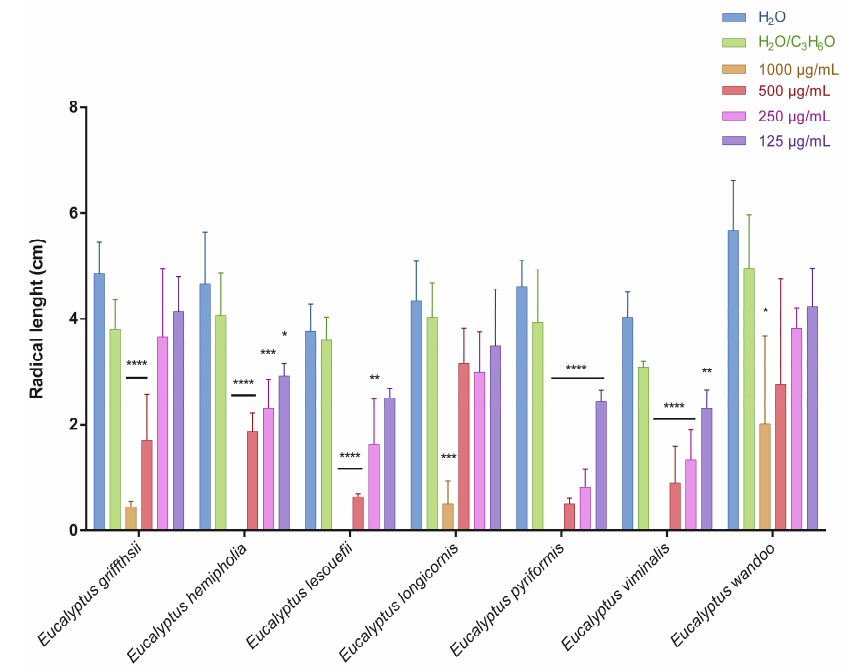
Figure 6. Radical length of Lolium multiflorum seeds after treatment with different concentrations (125–1000 µ g/mL) of Eucalyptus essential oils measured 120 h after sowing. Results are the mean ± standard deviation ( n = 3) of three independent experiments. * p < 0.05; ** p < 0.01, *** p < 0.001, **** p < 0.0001 compared to control (ANOVA followed by Dunnett’s multiple comparison test). The EOs from E. lesouefii and E. pyriformis were the most active against germination and radical elongation of S. arvensis . In fact, at the lowest doses tested (125 µ g/mL), the inhibition of germination was 93.1 and 96.6%, respectively, and the inhibition of radical elongation was 90.6 and 94.8%, respectively. E. griffithsii and E. viminalis EOs were